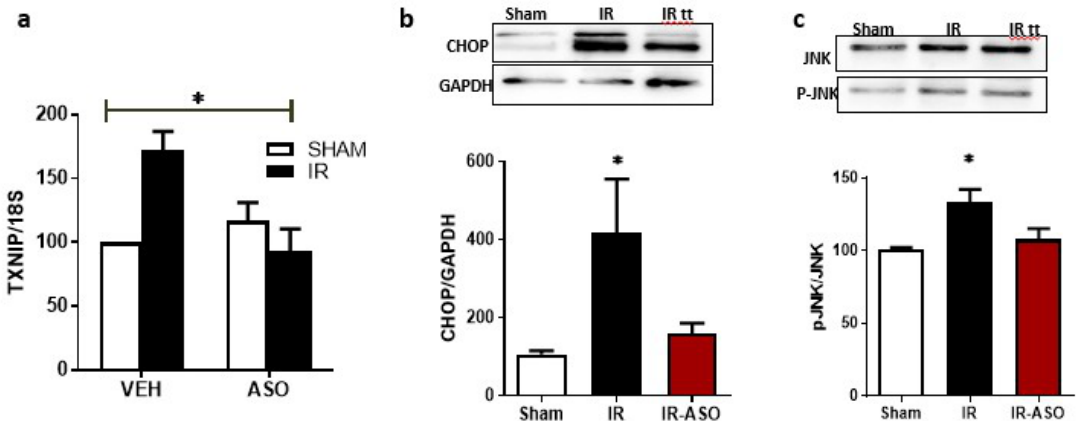
Figure 7. ( a ) Statistical analysis of mRNA level assessed by realtime-PCR showed that that interventional treatment with antisense oligomer (ASO); a novel specific TXNIP inhibitor; blunted the increase of TXNIP mRNA 14-days post IR-injury. (* p < 0.05 two-way ANOVA showed significant interaction of IR and treatment, N = 3–4) ( b , c ) Western blot analysis showed that interventional treatment with TXNIP-ASO blunted the increase of the ER-stress marker, CHOP and the apoptotic marker Phosphorylated-JNK expression after retinal IR. (* p < 0.05 vs. sham, n =